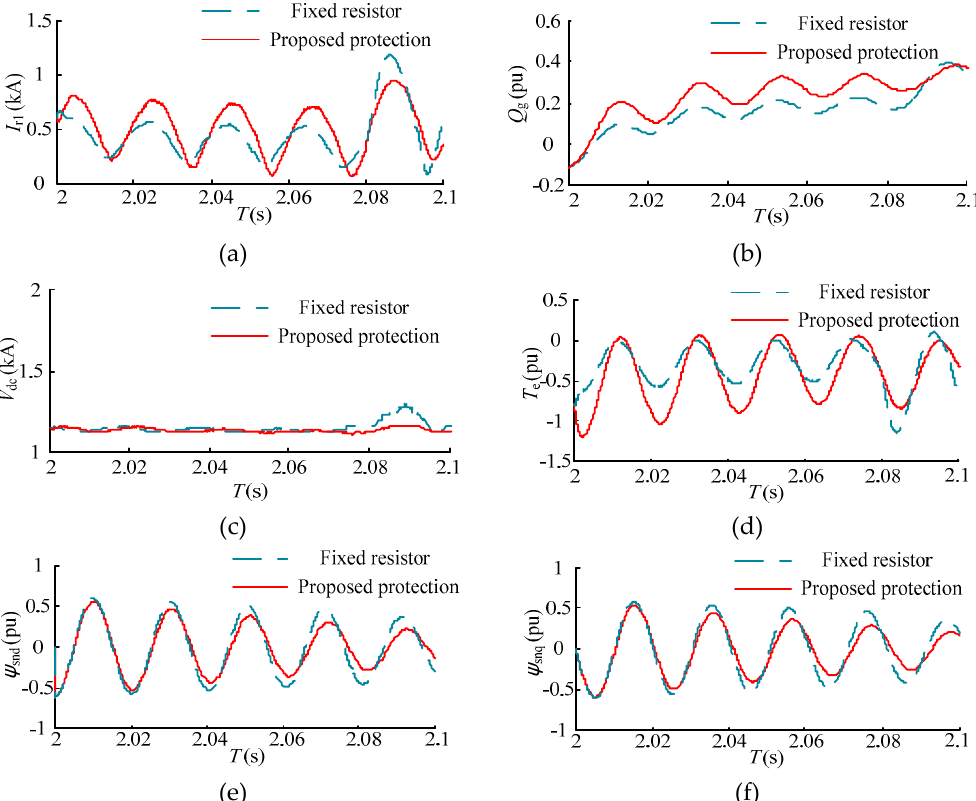
Figure 20. Comparison between proposed protection and fixed rotor braking resistor. ( a ) RSC current; ( b ) reactive power at the grid; ( c ) DC-link bus voltage; ( d ) electromagnetic torque; ( e ) the D-axis component of the stator transient flux linkage; and ( f ) the Q-axis component of the stator transient flux linkage.